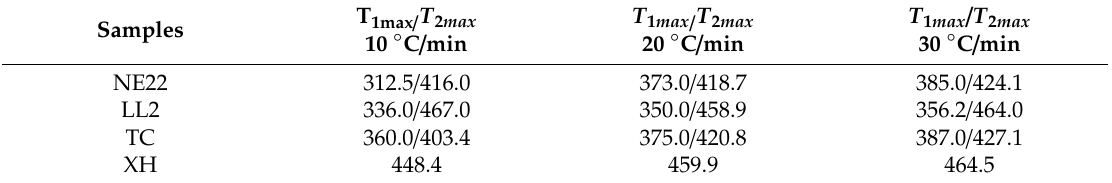
Table 7. T max for belt at different heating rates (10, 20, 30 °C/min) under nitrogen conditions.